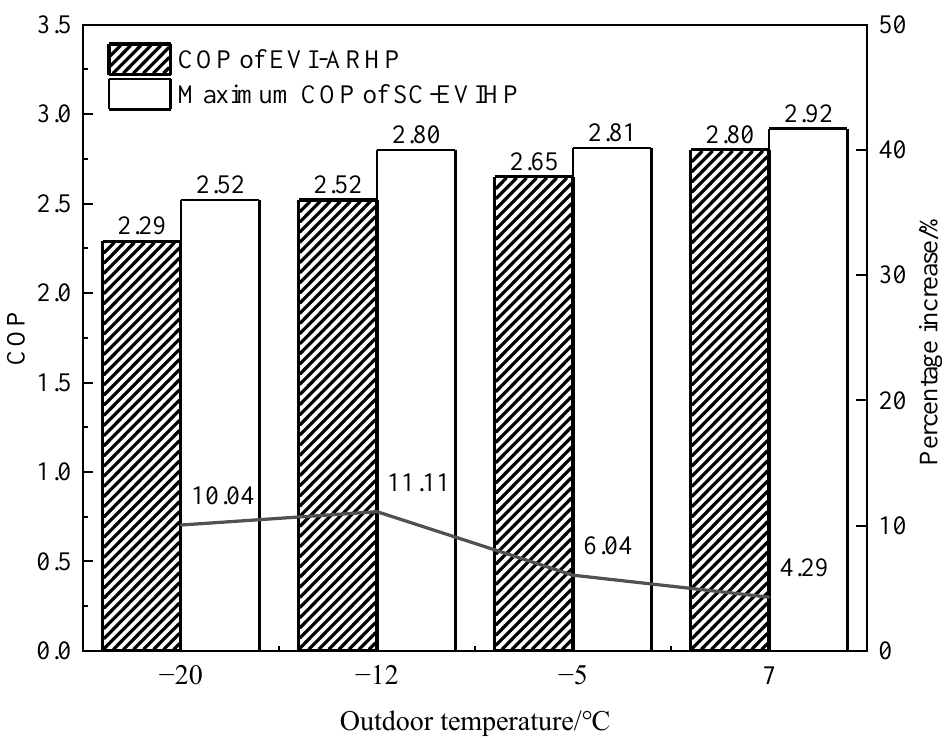
Figure 13. Heating capacity comparison at different outdoor temperatures.